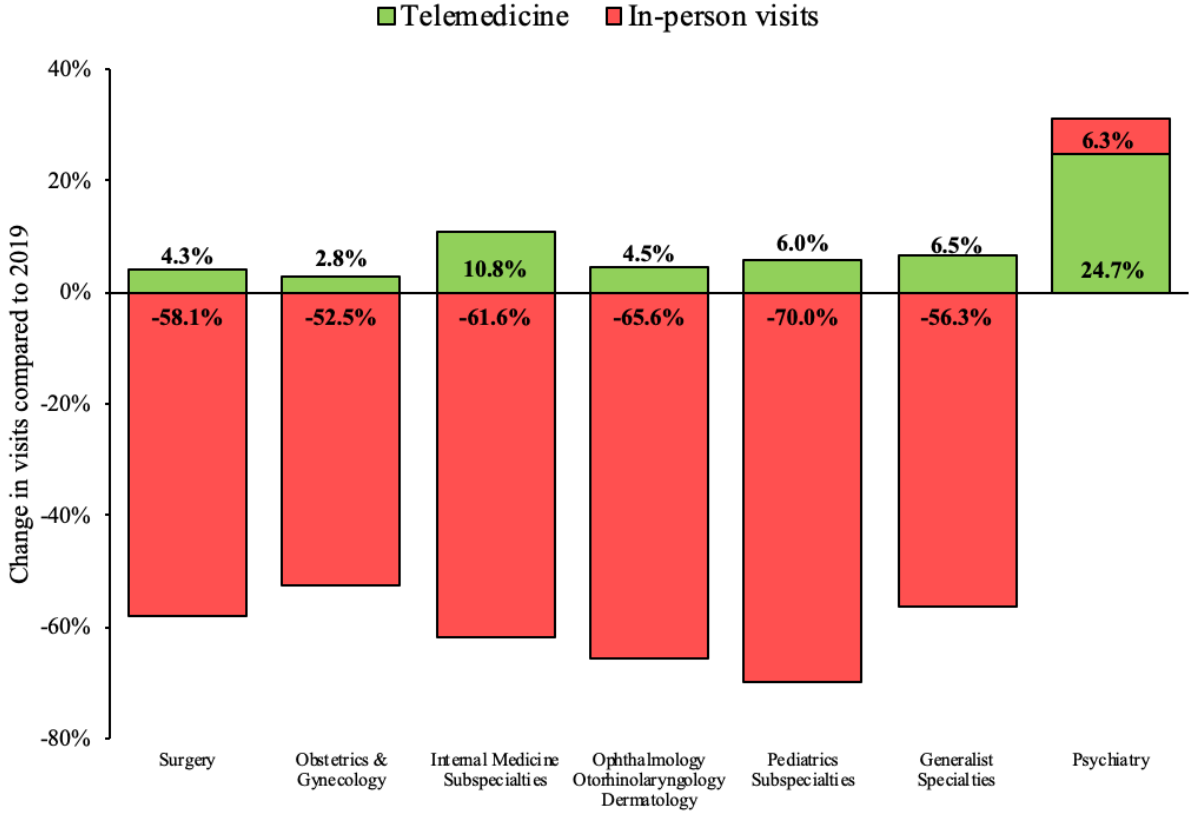
Figure 2. Rates of telemedicine and in-person visits by medical specialty.